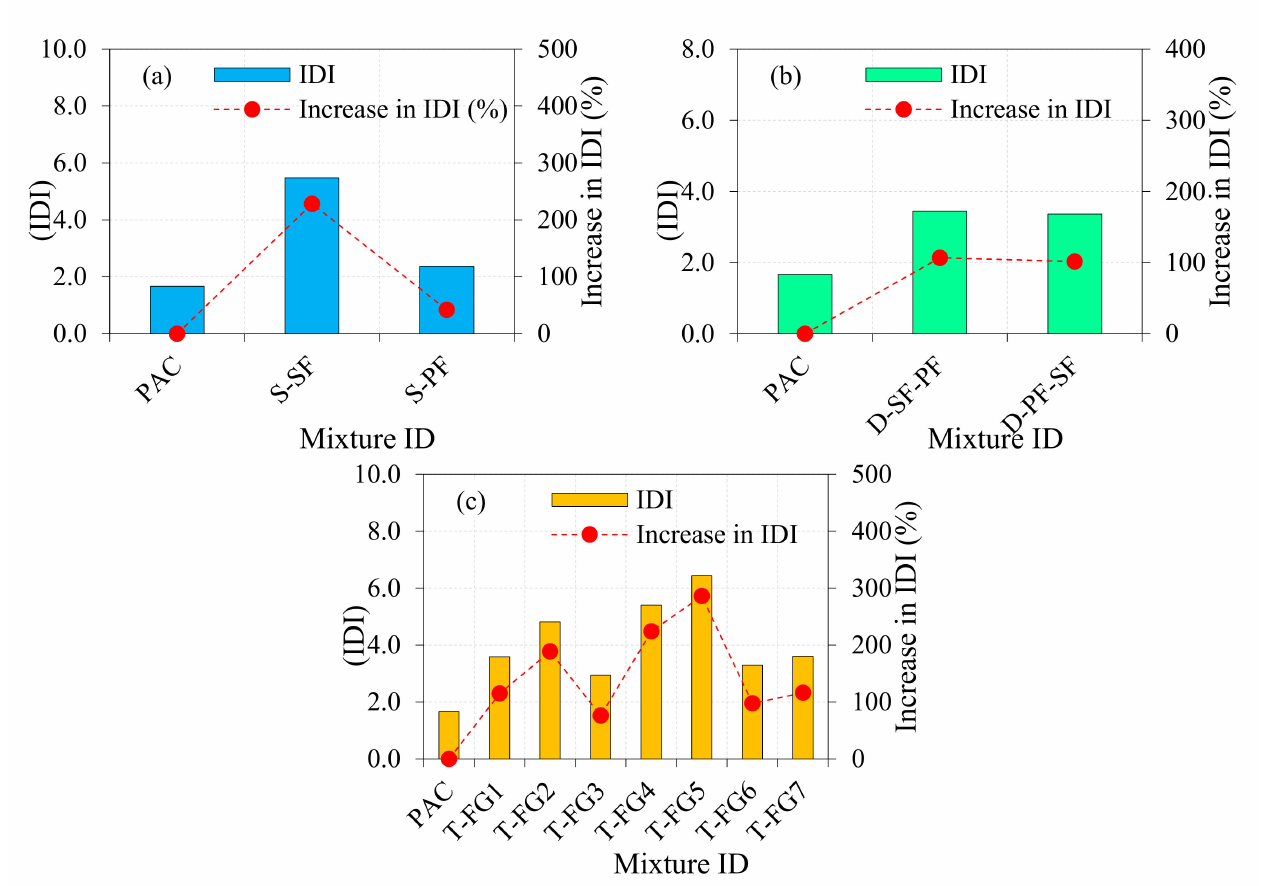
Figure 12. Ductility of specimens tested under of the modified impact test: ( a ) single-layer specimens, ( b ) double-layer specimens, ( c ) triple-layer